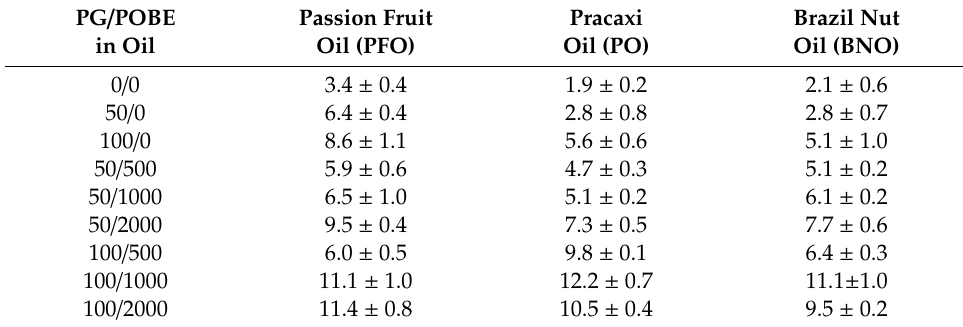
Table 4. Influence of PG / POBE (ppm / ppm) blends on the oxidative induction period (h) of reference vegetable oils.